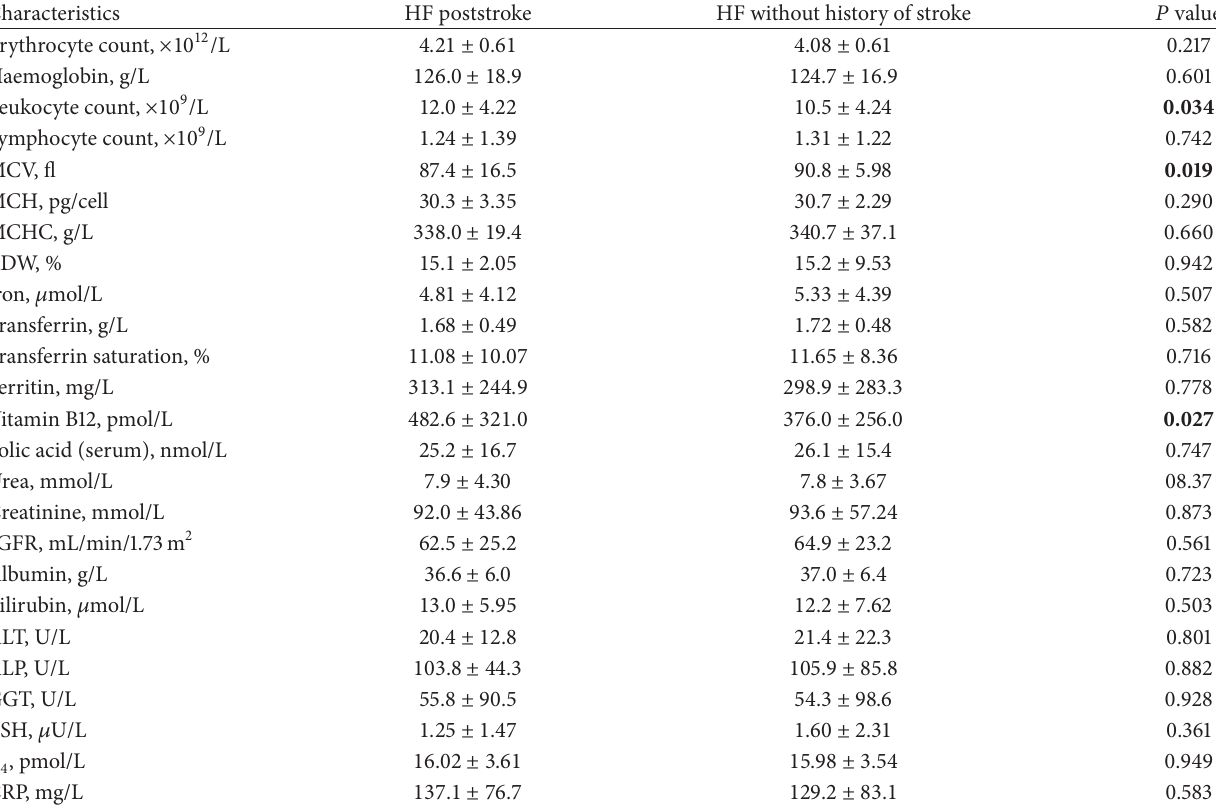
Table 2: Haematologic, renal, liver, and thyroid parameters in older hip fracture patients with and without history of stroke. Characteristics